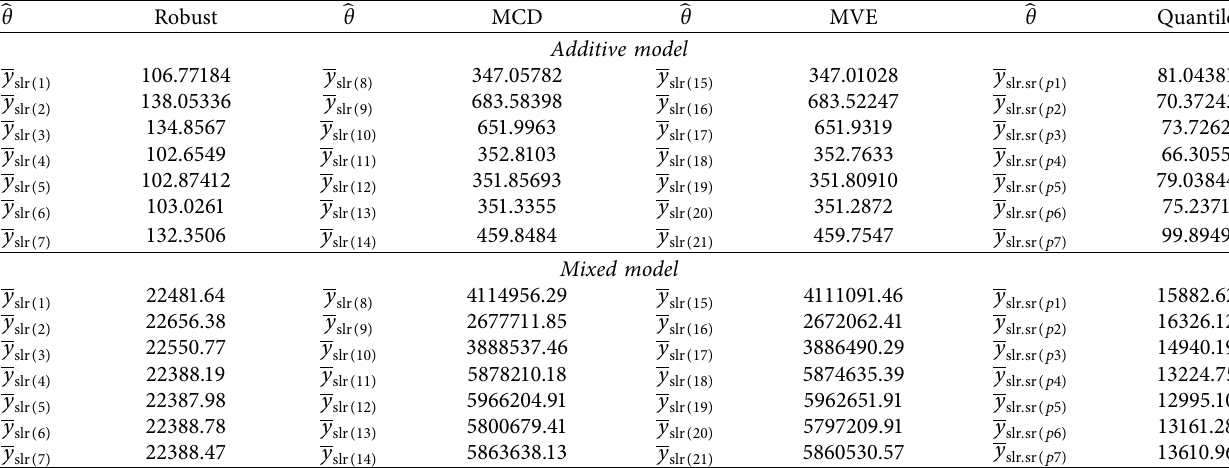
Table 5: Population-1 MSE for the mean estimators of the sensitive variable through using the additive and mixed models.